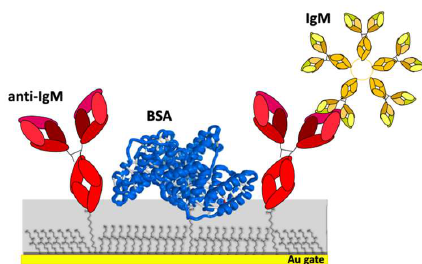
Figure 1. Capturing SAM, comprising both a chem-SAM of activated-and-blocked 3-mercaptopropionic acid (3-MPA) and 11-mercaptoundecanoic acid (11-MUA) and a bio-SAM of capturing antibodies.